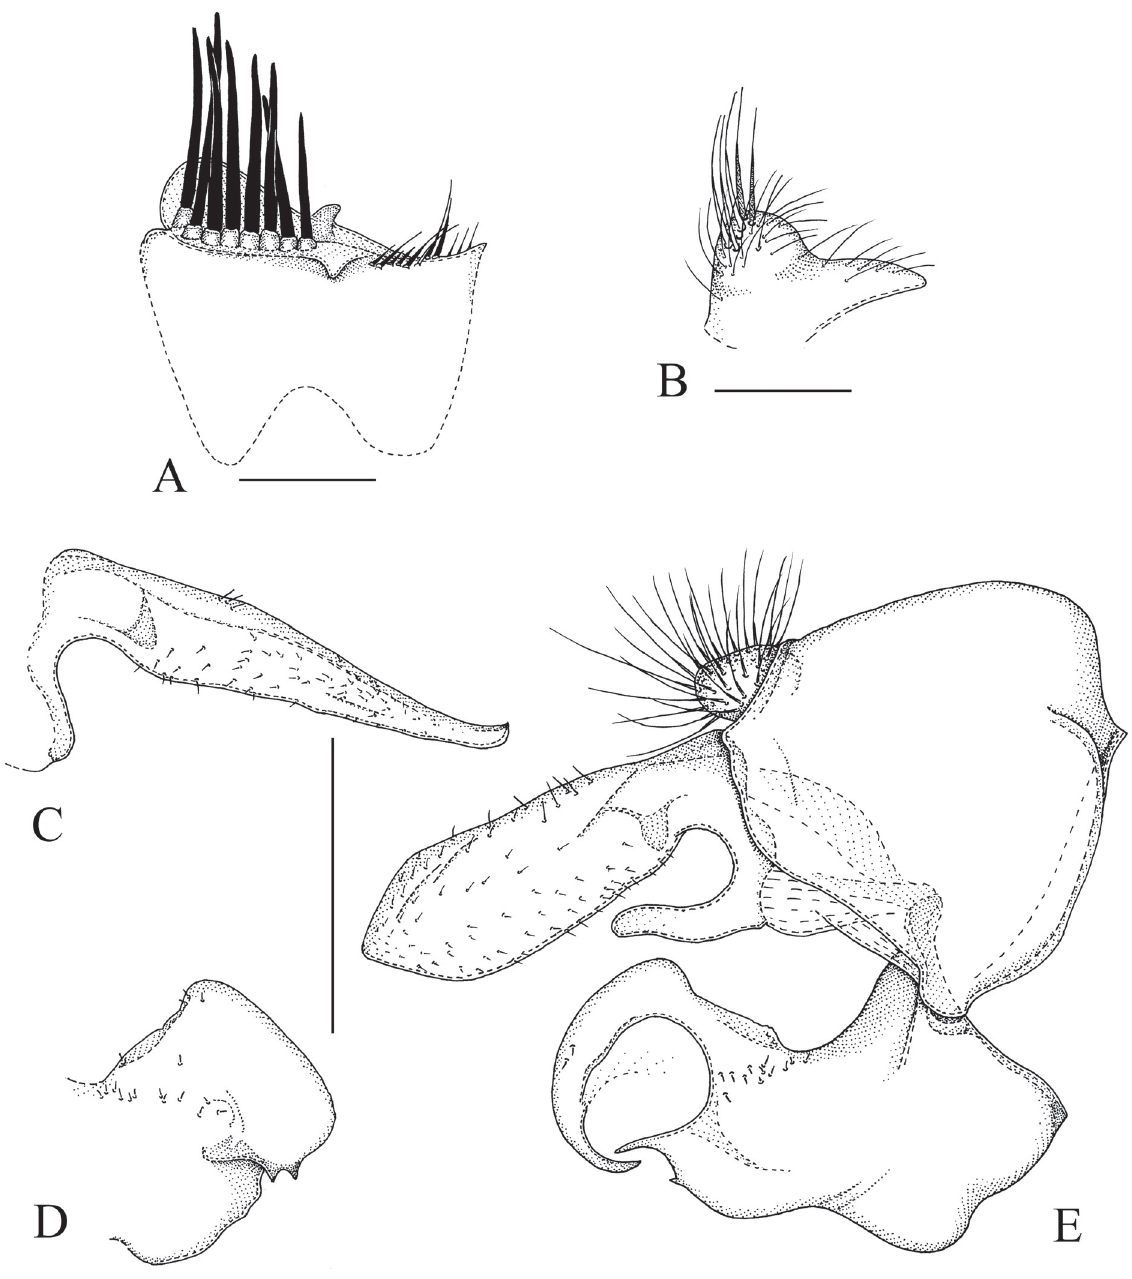
Fig. 16. Sphegina (Asiosphegina) bispinosa Brunetti , 1915, ♂ , India. A . Sternum IV, ventral view. B . Sternum VII, ventral view. C . Left surstylus, lateral view. D . Left superior lobe, lateral view. E . Genitalia, right side, lateral view. Scale bars = 0.5